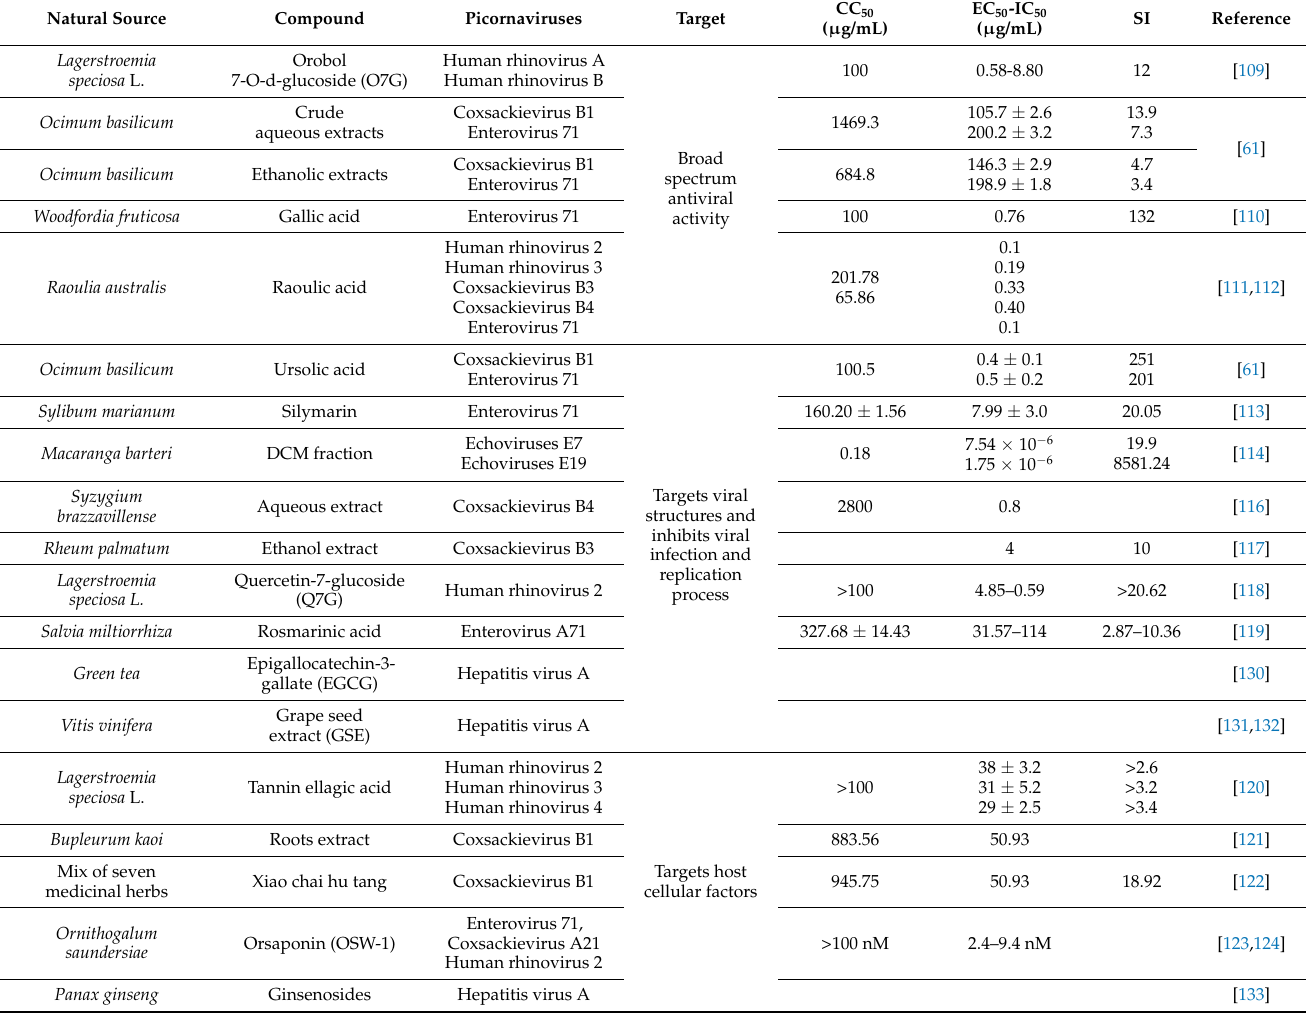
Table 8. Natural compounds and their antiviral targets against Picornaviruses.